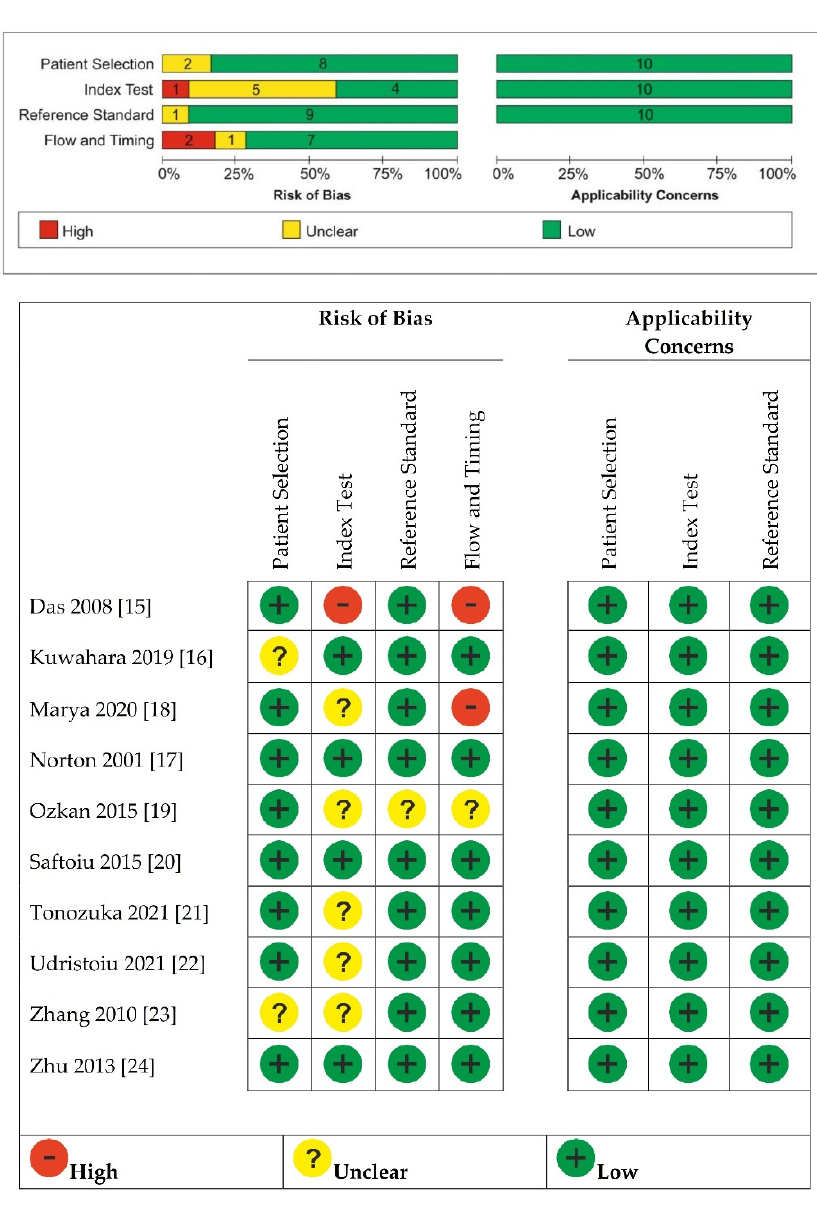
Figure 2. Quality assessment of included studies by using the QUADAS-2 assessment [15–24]. Das 2008 [17] and Marya 2020 [20] were considered having high risk of bias for flow and timing because not all patients received the same reference